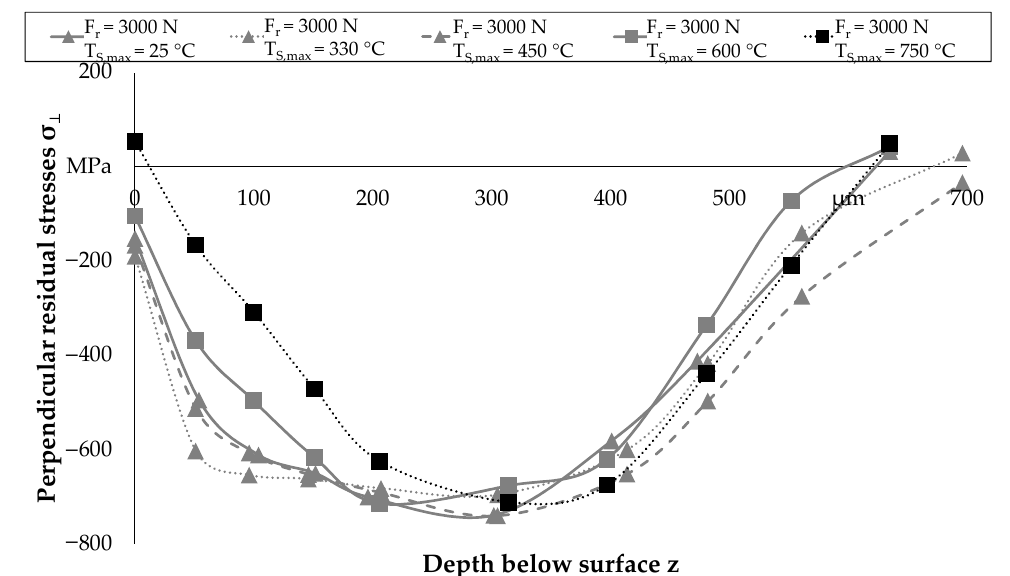
Figure 7. residual stress depth distribution perpendicular to the rolling direction for T S,max = 25 °C, 330 °C, 450 °C, 600 °C and 750 °C with the deep rolling force F r = 3000 N.